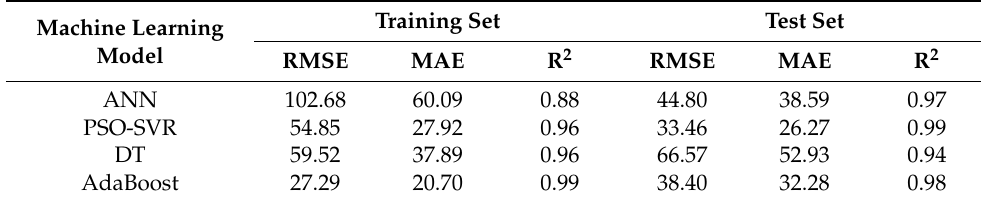
Table 3. Result comparison between machine learning